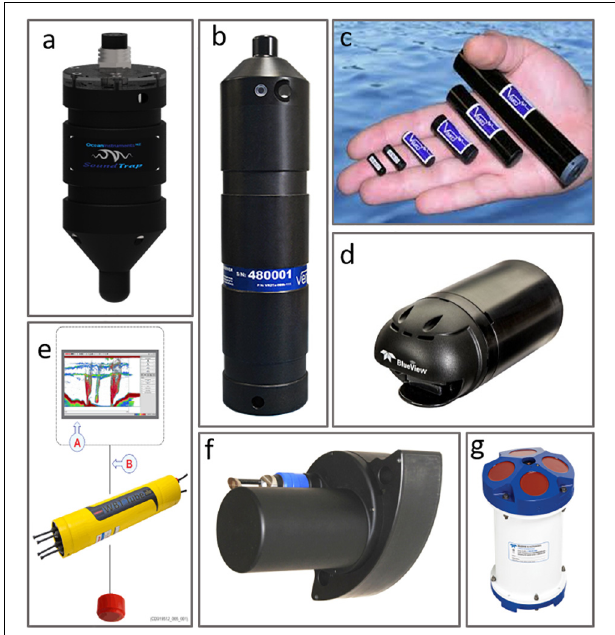
FIGURE 4 | Examples of acoustic instruments that can be attached to, or deployed by an industry ROV to collect scientific information including (a) OceanInstruments SoundTrap ST300 (PAM recorder), (b) Vemco acoustic telemetry receiver, (c) acoustic telemetry tags (Images courtesy of VEMCO, part of Innovasea), (d) Blueview M900-2250 imaging sonar (Images courtesy of Teledyne BlueView), (e) Simrad WBAT echosounder, (f) Norbit Subsea WBMS multibeam echosounder (for seafloor and water column), (g) Teledyne RDI ADCP (acoustic Doppler current